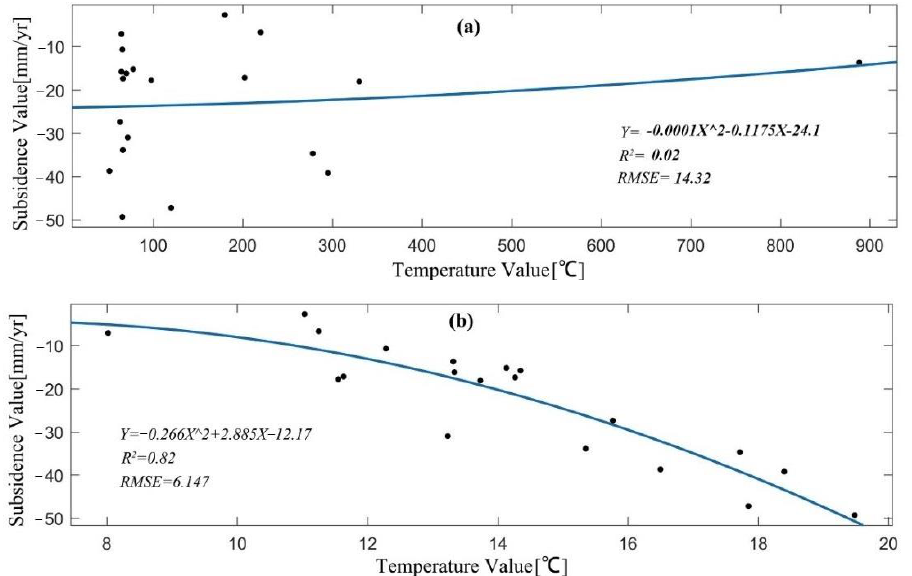
Figure 15. Relationship between the temperature and subsidence rate of coal fire points in the study area: ( a ) Relationship between the measured temperature and subsidence rate of coal fire points; ( b ) Relationship between time-series average temperature and subsidence rate of coal fire points.